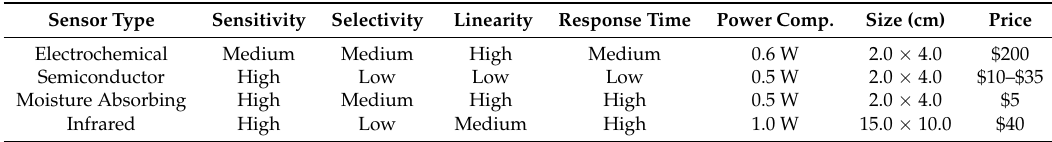
Table 5. Comparison of different sensing module components.